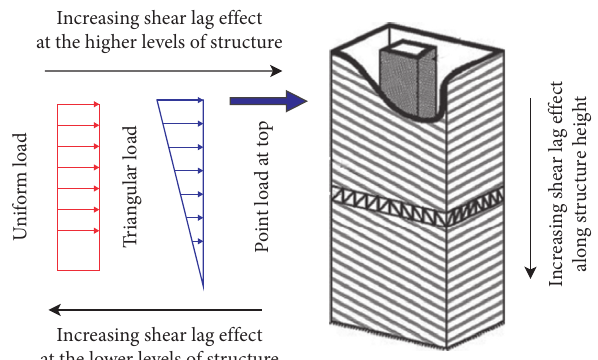
Figure 9: Shear lag effect against load distribution along the building